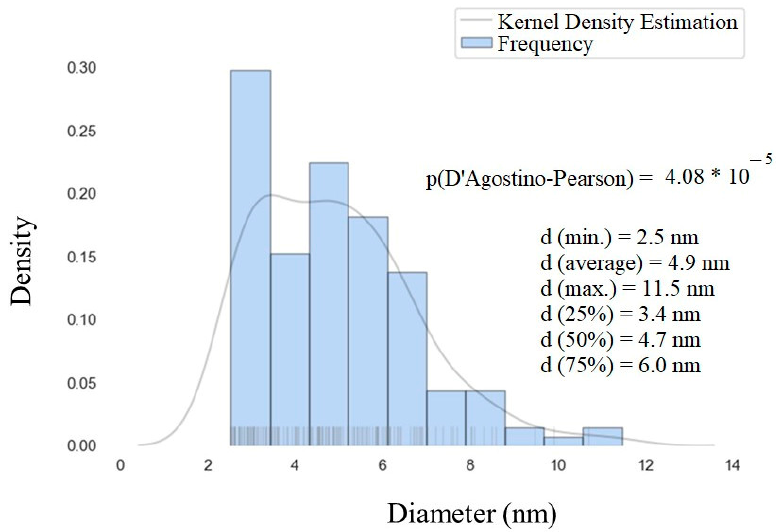
Figure 11. Histogram of the particle size distribution obtained from the STEM images of SiO 2 - Gd 2 O 3 :Eu 3+ (1%).